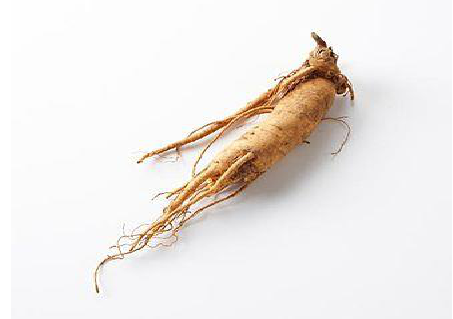
Fig. 1: A picture of the root of Pan Ginseng (Korean)